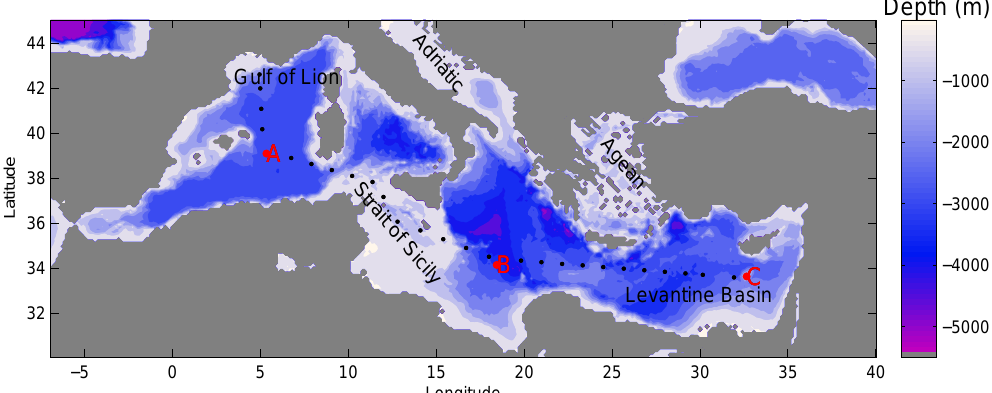
Fig. 1. Bathymetric map of the Mediterranean Sea; short duration stations (SD) profiles are marked by black dots, long duration LD stations Figure 1: Bathymetric map of the Mediterranean sea, short duration stations (SD) pro(cid:28)les are (A, B, C) at the eddy centers are marked by red marked by black dots, long duration LD stations (A,B,C) at the eddy centers are marked by red dots